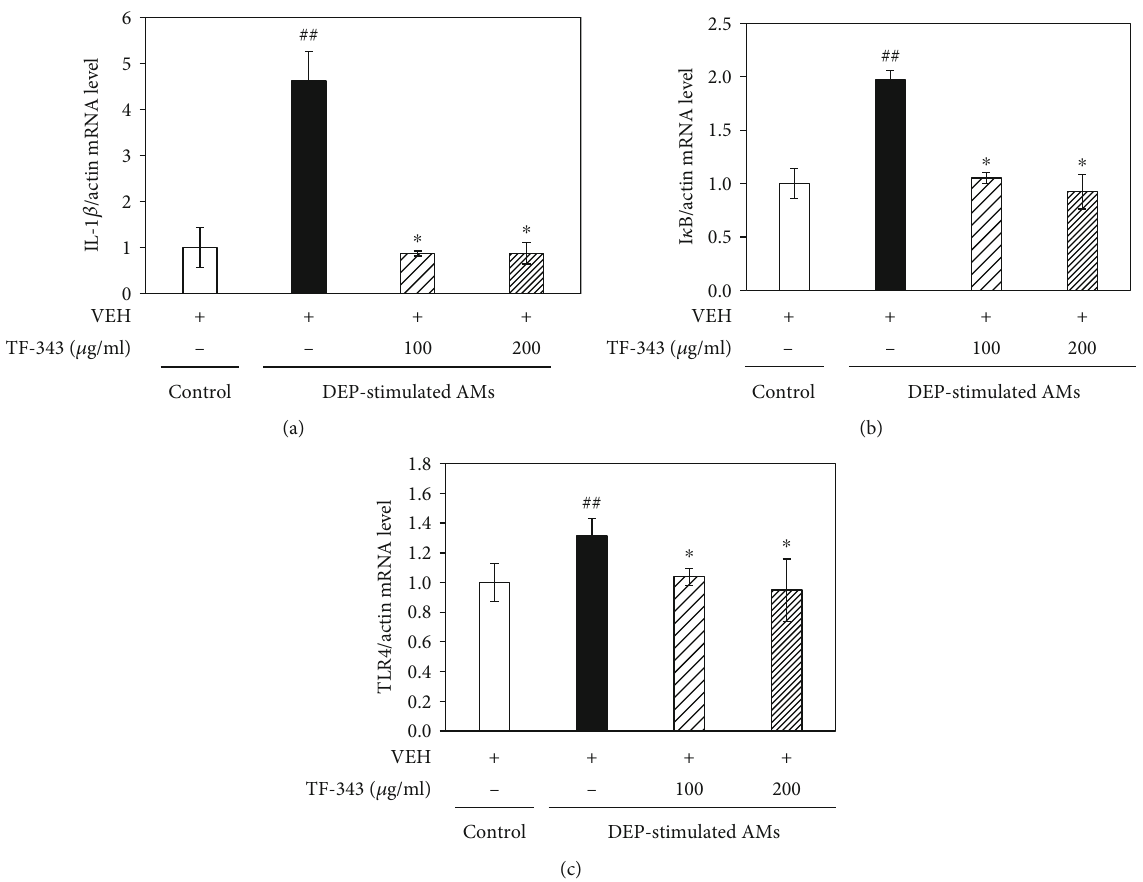
Figure 6: Expression levels of in fl ammation-related genes including (a) IL-1 β , (b) I κ B, and (c) TLR4 in DEP-stimulated AMs. AMs were pretreated overnight with TF-343 (100 or 200 μ g/ml) before adding DEP (100 μ g/ml). Real-time PCR analysis was performed 48 h after DEP stimulation. Data represent mean ± SD ( n = 5 per group). ## P < 0 : 01 vs. control, ∗ P < 0 : 05 vs. DEP-treated